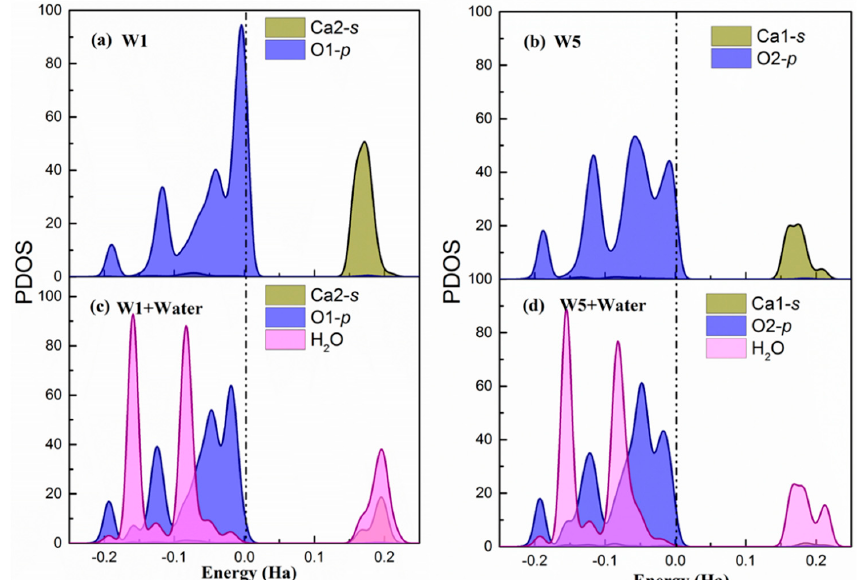
Figure A2. Surface (101) ( a , b ) The partial density of states of W1 and W5 adsorption sites on the relaxed surface. ( c , d ) The partial density of states of W1 and W5 adsorption sites after being water adsorbed on the surface. The dash dot line indicates the Fermi level.